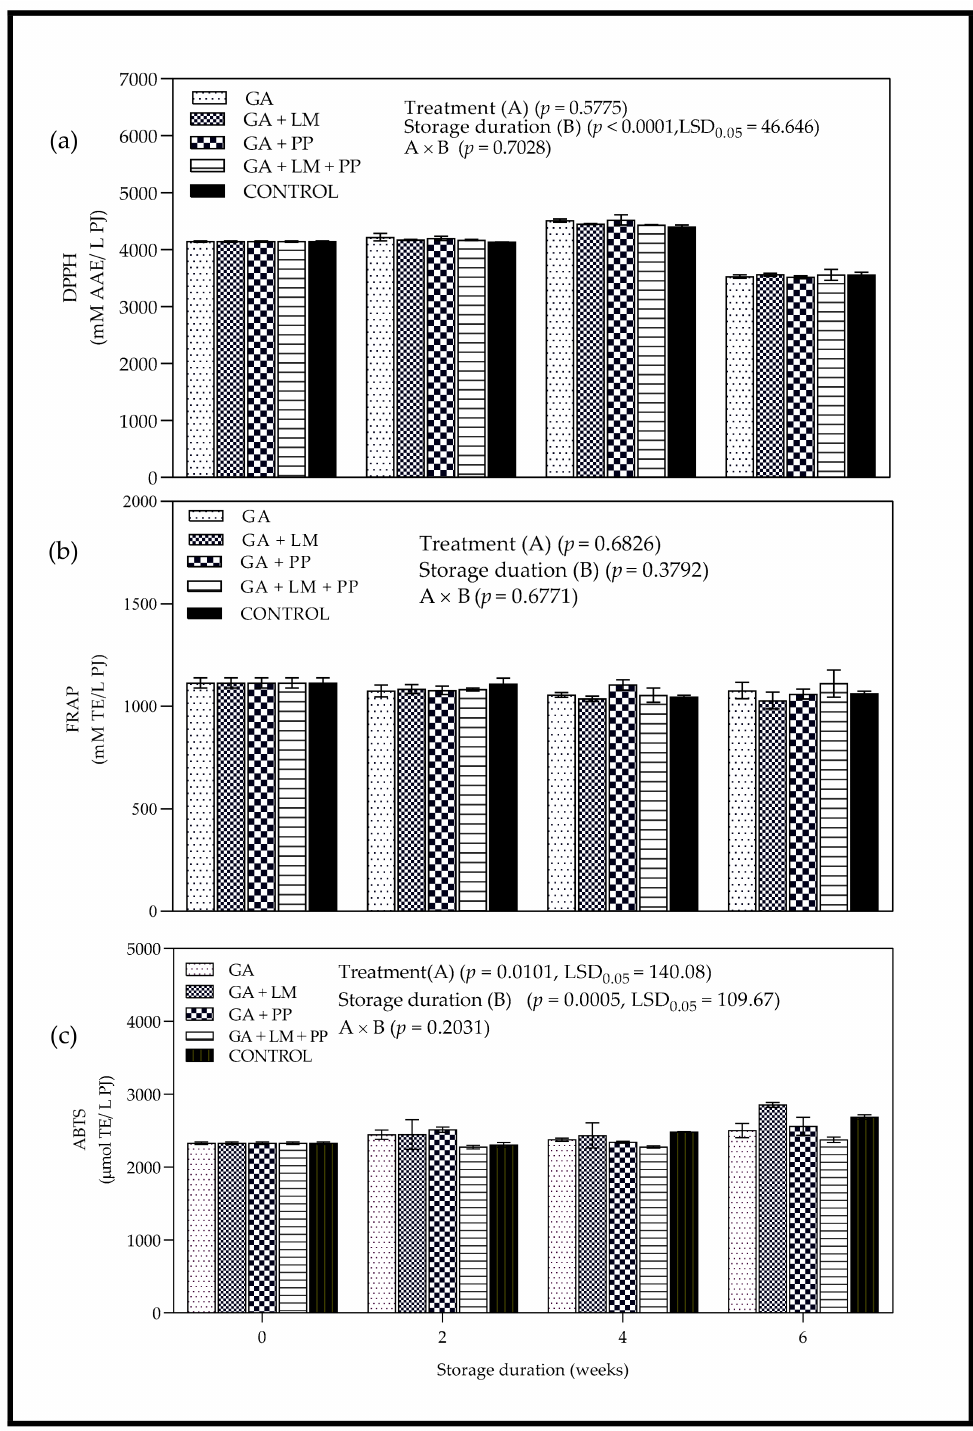
Figure 14. Antioxidant properties determined by ( a ) DPPH (mM AAE/L PJ), ( b ) FRAP (mM TE/L PJ) and ( c ) ABTS + ( µ mol TE/L PJ) of ‘Wonderful’ pomegranate whole fruit coated with gum arabic (GA) coatings enriched with lemongrass oil (LM) (0.1% v/v ) and/pomegranate peel extract (PP) (1% w/v ) and stored at 5 ± 1 ◦ C (95 ± 2% RH) for 6 weeks. Vertical bars represent the standard error (SE) of mean values calculated from three measurements. LSD 0.05 represents least significant difference ( p <